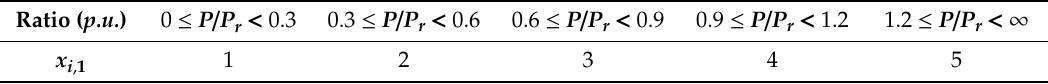
Table 1. Performance values x i ,1 for 1st criterion.